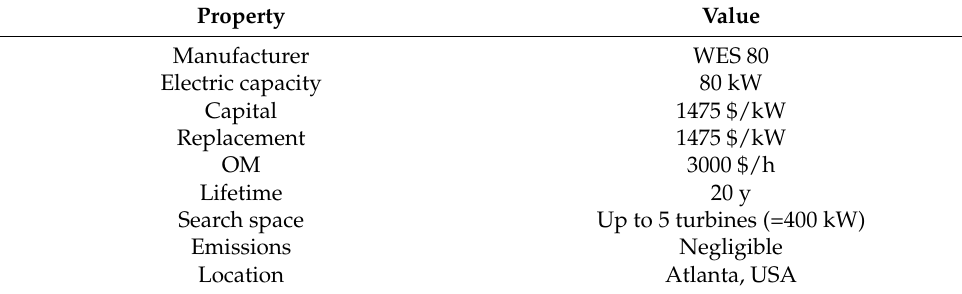
Table A11. Wind turbine parameters [42,43,48].